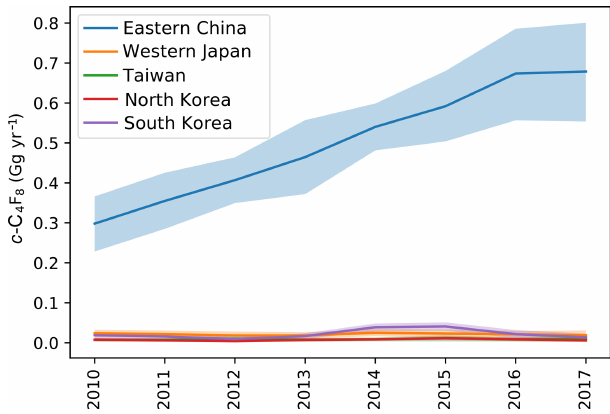
Figure 6. c -C 4 F 8 emissions in eastern Asia as determined by the NAME-HB regional inversion of measurements at the Gosan sta- tion, Jeju Island, South Korea, are dominated by emissions from China (blue). Emissions from western Japan (orange) and South Korea (violet) are much smaller; the latter show a small maximum in 2014 and 2015. Emissions from Taiwan (green) and North Korea (red) are also small. Shadings represent uncertainty bands of emis-